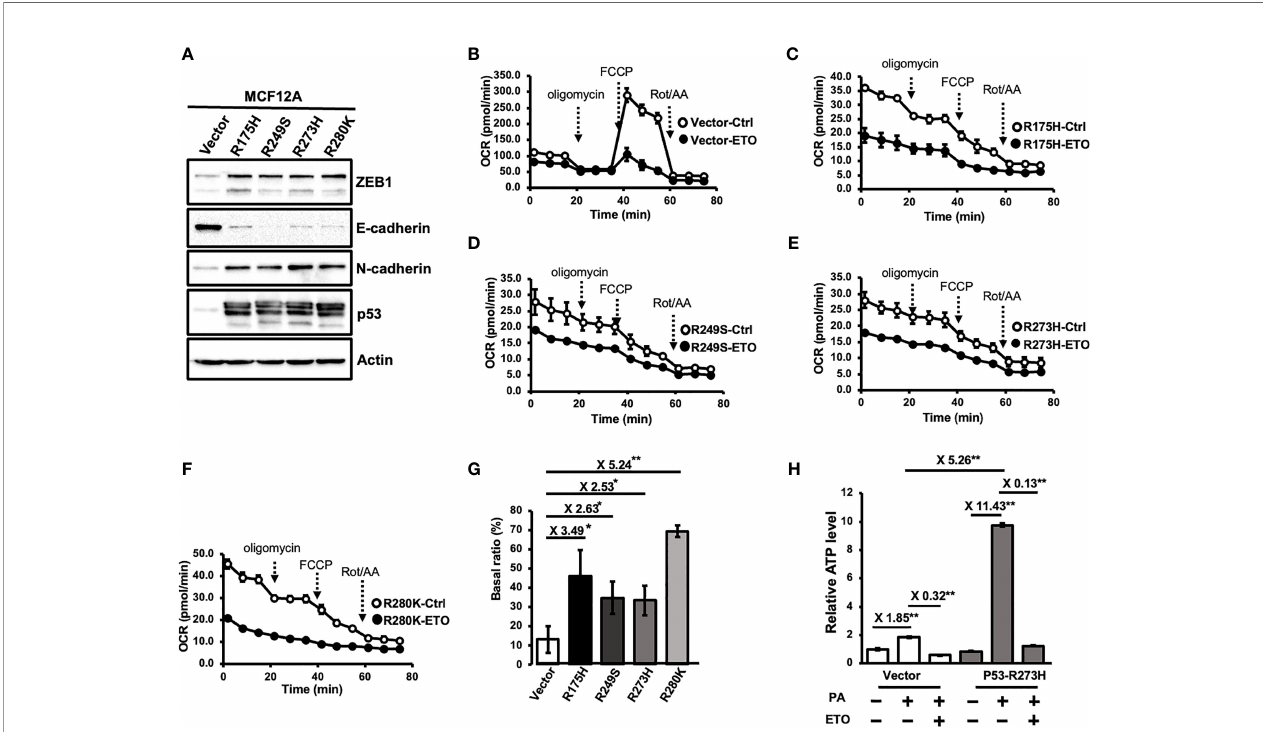
FIGURE 1 | Mutant p53 enhances fatty acid beta-oxidation (FAO) activity in immortal mammary epithelial cells. (A) Stable expression of p53 hot-spot mutations in MCF12A cells. The expressional levels of ZEB1, E-Cadherin, N-Cadherin, p53, and Actin were examined by Western Blotting. All of the immunoblotting analysis was performed under the same experimental conditions. Results were obtained from the same or different PAGEs using the same samples and presented as cropped images. (B – G) Mutant p53 enhances FAO activity. FAO activity of MCF12A-Ctrl (B) . MCF12A-p53 R175H (C) . MCF12A-p53 R249S (D) . MCF12A-p53 R273H (E) and MCF12A-p53 R280K (F) were measured by seahorse metabolic fl ux analyzer with FAO assay kit. (G) the FAO activity of individual cell lines was determined by averaging Basal ratios from three independent experiments (mean ± SD, n = 3). Basal ratio = (basal OCR Ctrl - basal OCR ETO )/basal OCR Ctrl . The two sides of the lines above the bars indicated the comparison of each Mutp53 to the control, and the value of fold changes with the asterisks representing signi fi cance was marked above the line. Data were analyzed by unpaired t-test. *p < 0.05; **p < 0.01. (H) FAO-produced ATP is increased by the expression of p53 mutant. MCF-12A-Ctrl (Vector) and MCF12A-P53-R273H cells (P53-R273H) were treated with palmitate and/or ETO (2 m M) and then subjected to the ATP assay to measure the steady- state ATP level (mean ± SD, n = 3). The relative ATP level was plotted by comparing to the ATP level of the Vector group without the treatment of PA. The two sides of the lines above the bars indicated the comparison of the two groups, and the value of fold changes with the asterisks representing signi fi cance was marked above the line. Data were analyzed by unpaired t-test. **p <